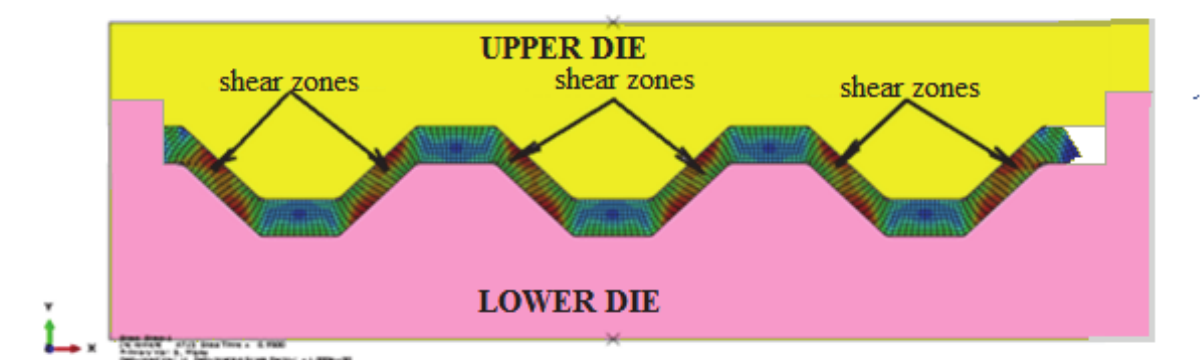
Figure 4: Illustration of the plastic deformation zones during the CGP process.